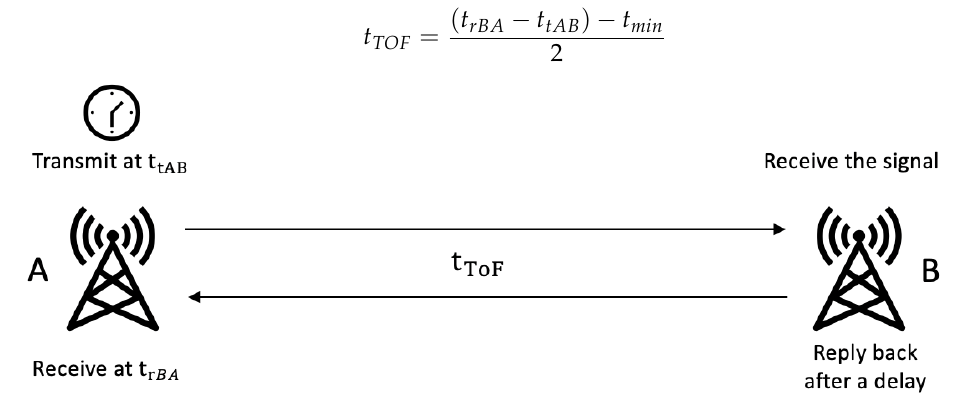
Figure 2. TOF—based distance